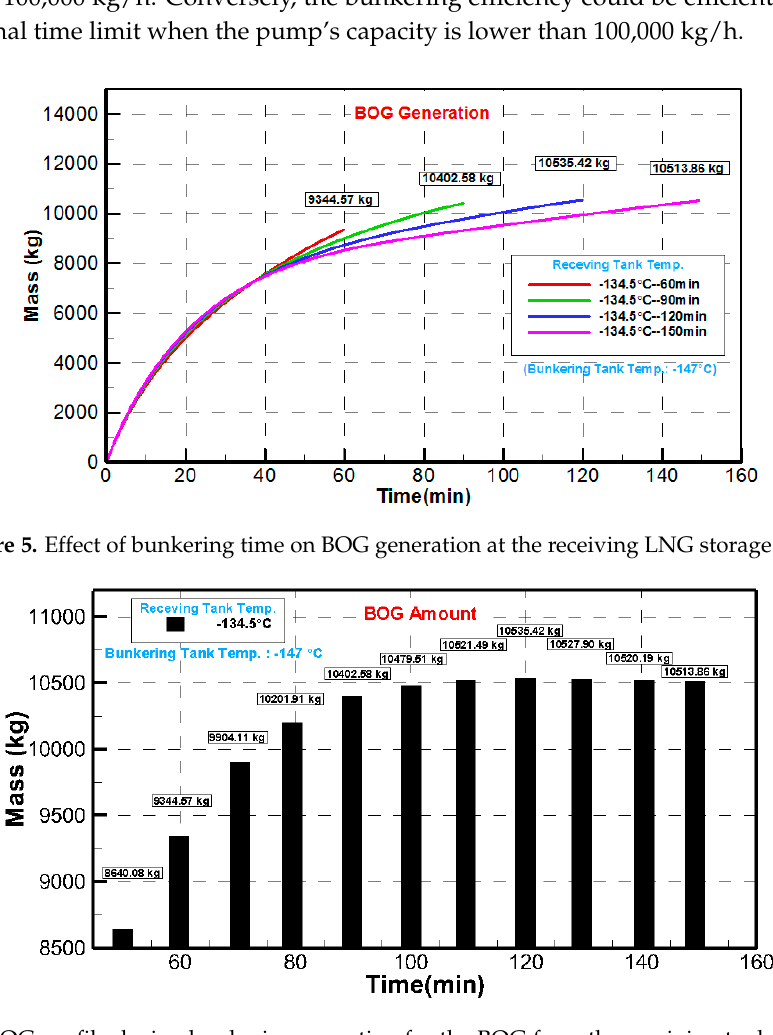
Figure 6. BOG profile during bunkering operation for the BOG from the receiving tank at different bunkering time limits (50–150 min.).